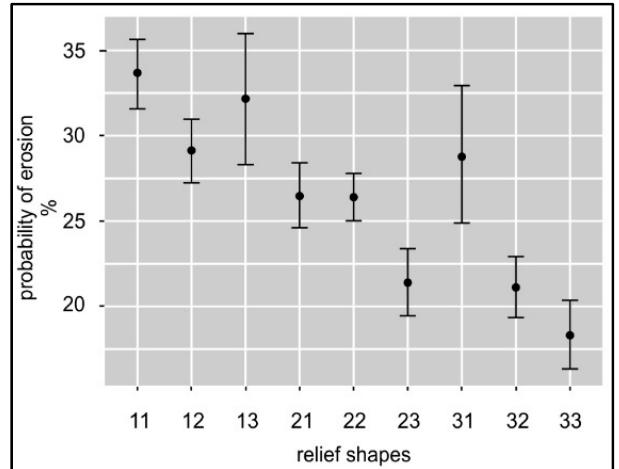
Figure 6. Shapes of the relief category: 11 (convex–convex), 12 (linear–convex), 13 (concave–convex), 21 (convex–linear), 22 (linear–linear), 23 (concave–linear), 31 (convex–concave), 32 (linear–concave), 33 (concave–concave).